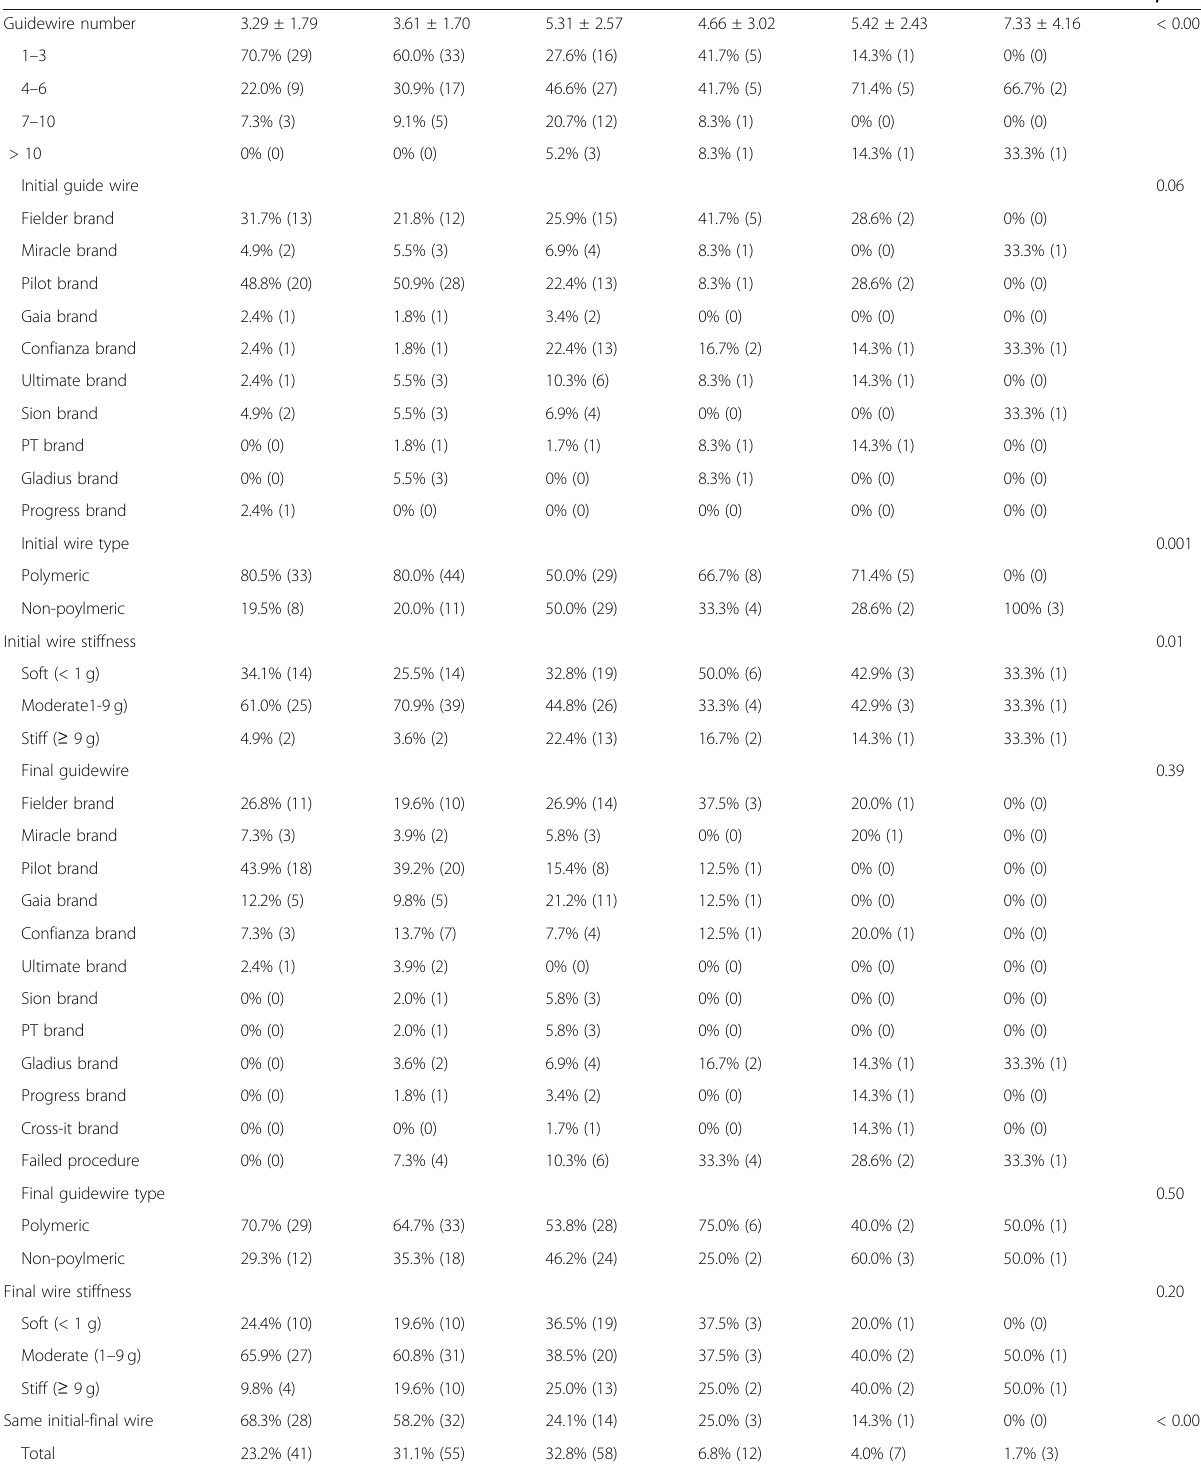
Table 7 Distribution of first-choice and final crossing guidewire characteristics according to EuroCTO